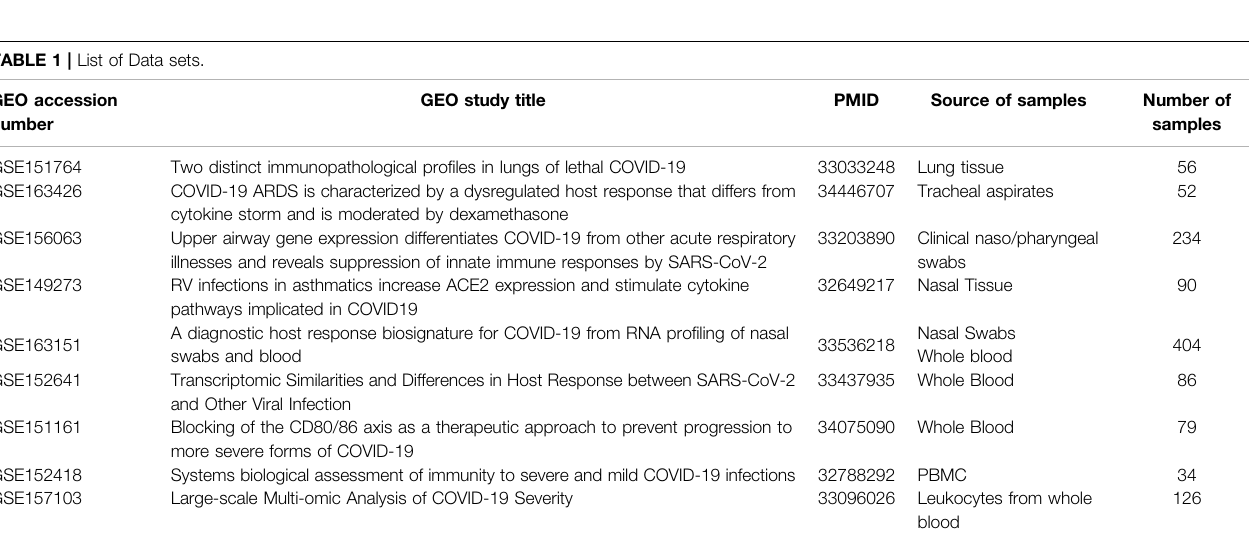
TABLE 1 | List of Data